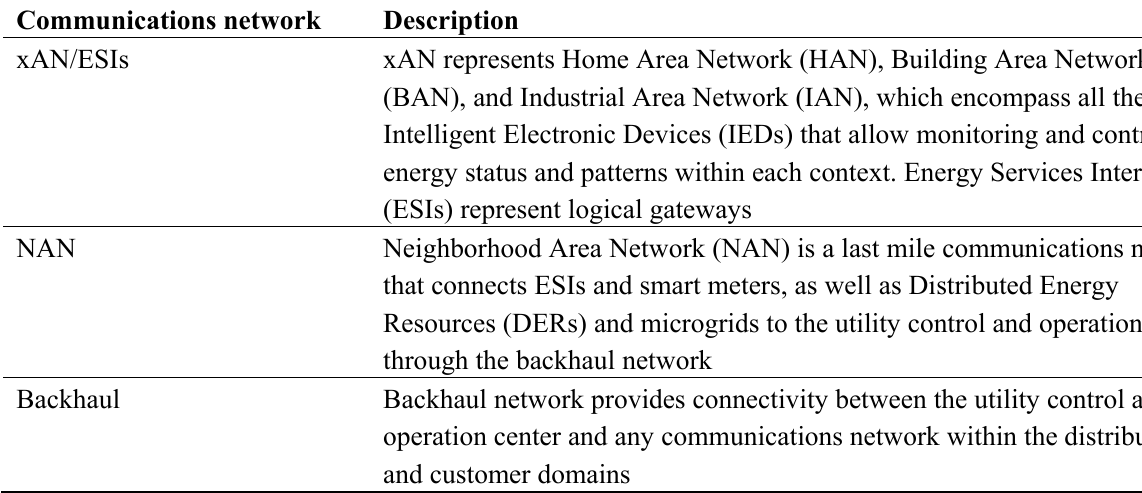
Table 2. Communications networks defined in the IEEE 2030 CT-IAP of special interest to this